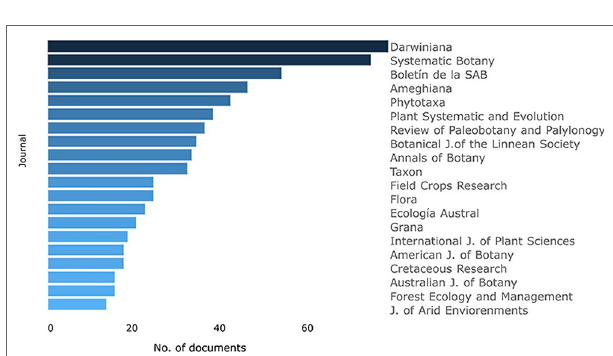
FIGURE 4 | The number of herbaria-based-research articles published from 1993 to 2018 in the first 20 journals, based on the bibliometric analysis of publications stored at Scopus database from 1993 to 2018 (refer to the text to see filters of the search).